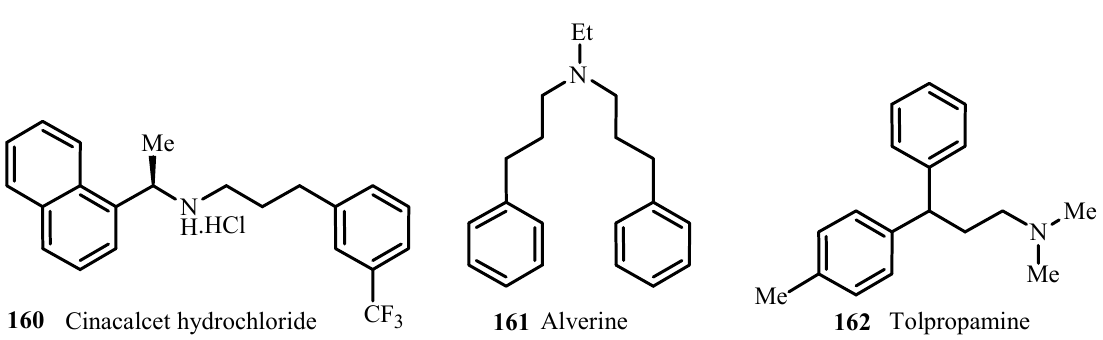
Figure 24. Lab scale preparation drugs reviewed by Biajoli et al. [85].